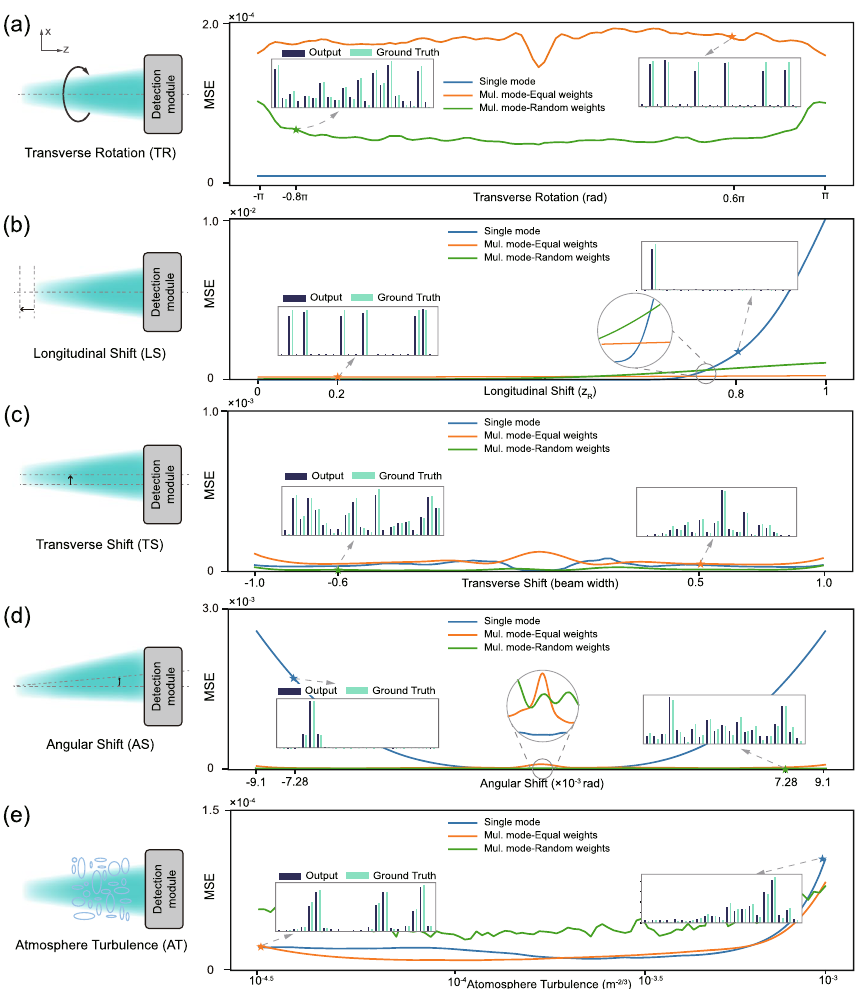
Fig. 4 Robustness analysis of the POAMS against adverse conditions. Left panel: schematic diagrams of different adverse conditions. In the right panel, different curves represent the MSE values between POAMS outputs and ground truths after distortions on different datasets. Inset: randomly selected OAM spectrum results (TC range: − 10 ~ 10) under corresponding adverse conditions. Every MSE value on curves is obtained from the average of 21 test modes. The test models in ( c ), ( d ) and ( e ) are fine-tuned with new electronic neurons to compensate for potential